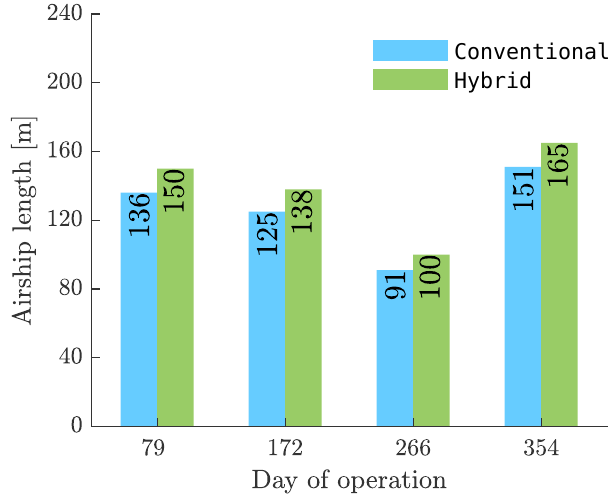
Figure 19. Airship length.